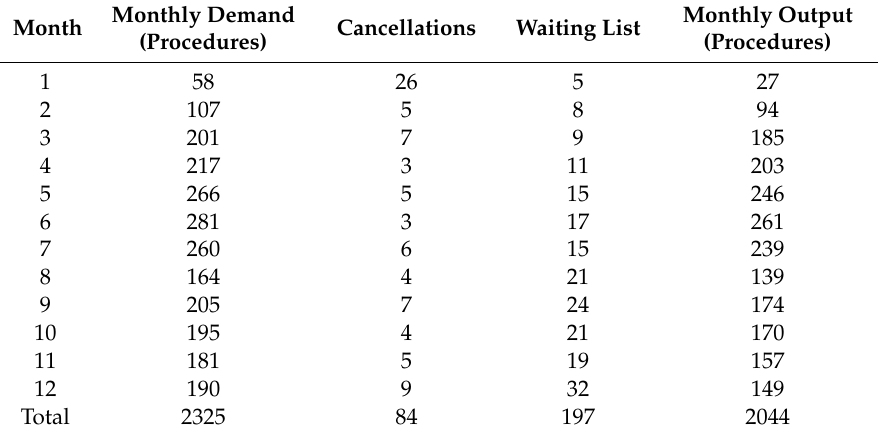
Table 2. Monthly comparison table of production and demand in the angiography room.